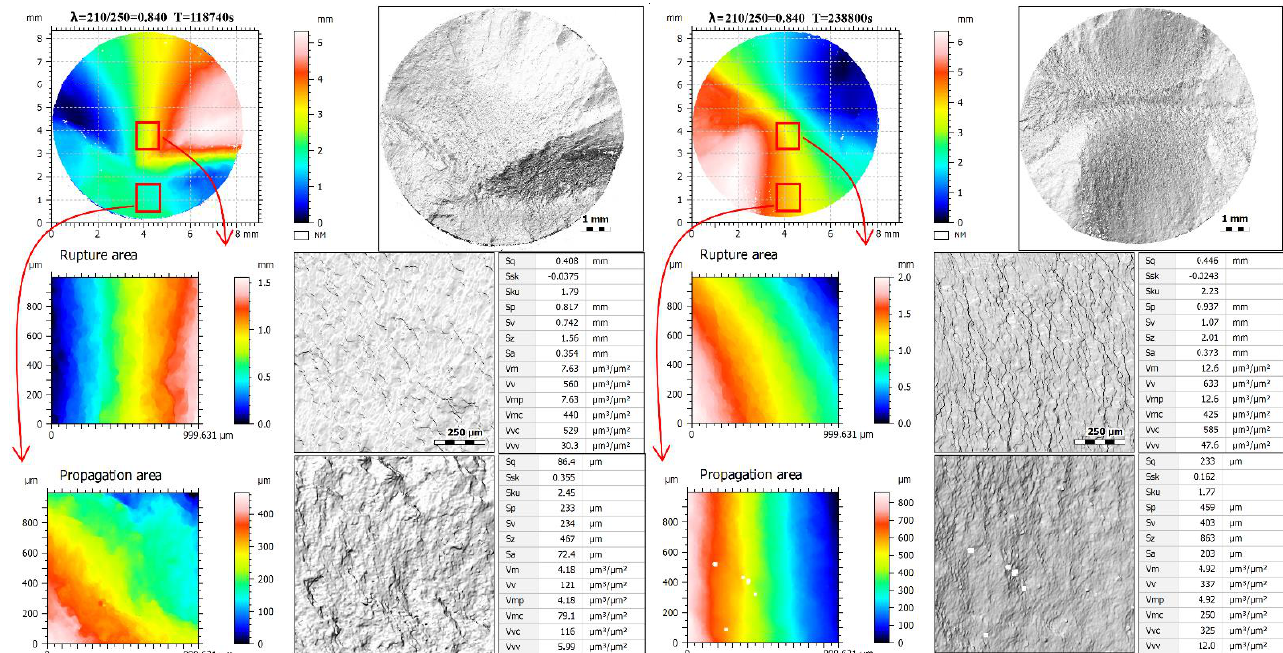
Figure 6. Visualization at different applied ratios of maximum stresses λ for the investigated ROIs: (1) total; (2) propagation; (3) rupture.